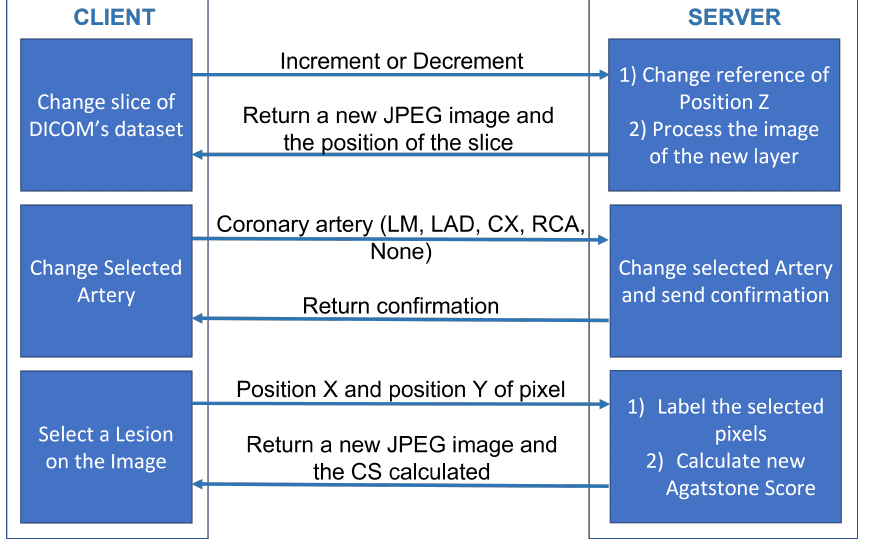
Figure 5. User functions in the web